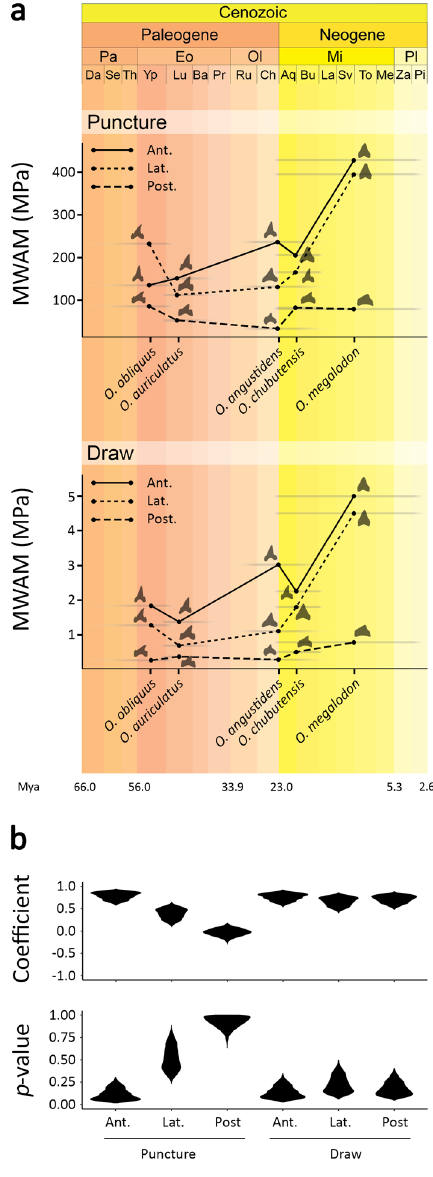
Figure 2. ( a ) Von Mises stress mesh-weighted arithmetic means (MWAM) calculated for anterior ( Ant. ), lateral ( Lat. ), and posterior ( Post. ) teeth of the five analysed otodontid species, simulating puncture and draw scenarios with scaled force magnitude. Data are shown in a temporal context (in million years ago, Mya ) where stratigraphic range of each taxa is represented by grey bars (stratigraphic ranges based on Cappetta 1 and Diedrich 9 ). ( b ) Density distributions of coefficients and p values derived from correlation analyses between von Mises stress MWAM and species age (randomly selected within their chronostratigraphic range, n = 10,000). Epoch: Pa, Paleocene; Eo, Eocene; Ol, Oligocene; Mi, Miocene; Pl, Pliocene; Age: Da, Danian; Se, Selandian; Th, Thanetian; Yp, Ypresian; Lu, Lutetian; Ba, Bartonian; Pr, Priabonian; Ru, Rupelian; Ch, Chattian; Aq, Aquitanian; Bu, Burdigalian; La, Langhian; Sv, Serravalian; To, Tortonian; Me, Messinian; Za, Zanclean; Pi,